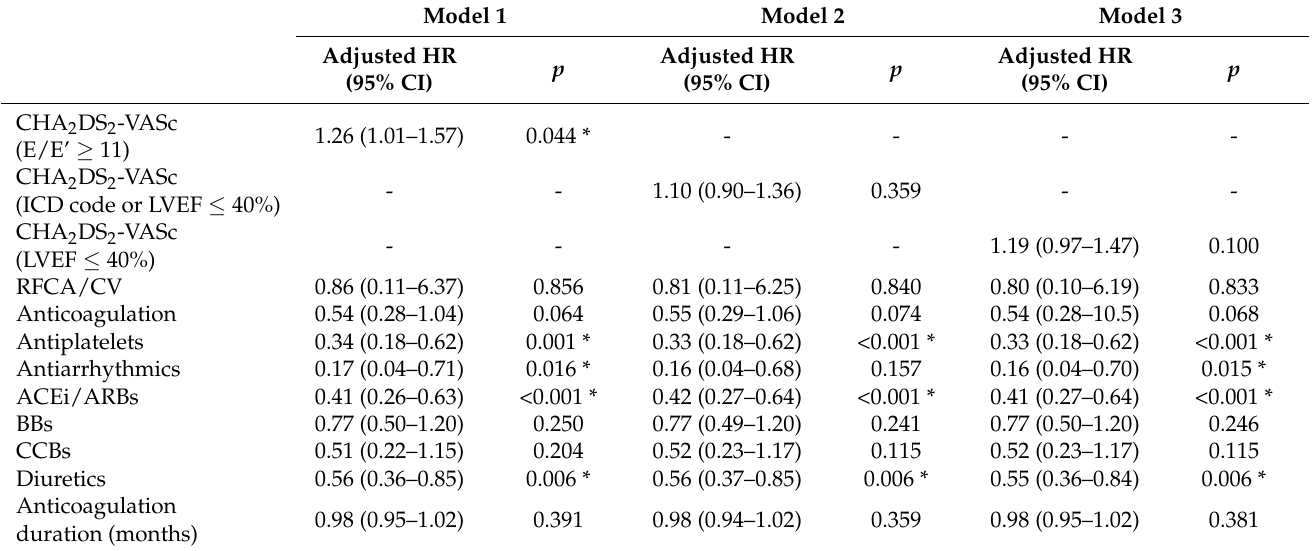
Table 1. Adjusted hazard ratio and 95% confidence intervals of other adjusted variables are shown in Supplemen- tary Table S2. * p < 0.05. Table 4. All covariates in the multivariable Cox regression models in predicting composite adverse thromboembolic